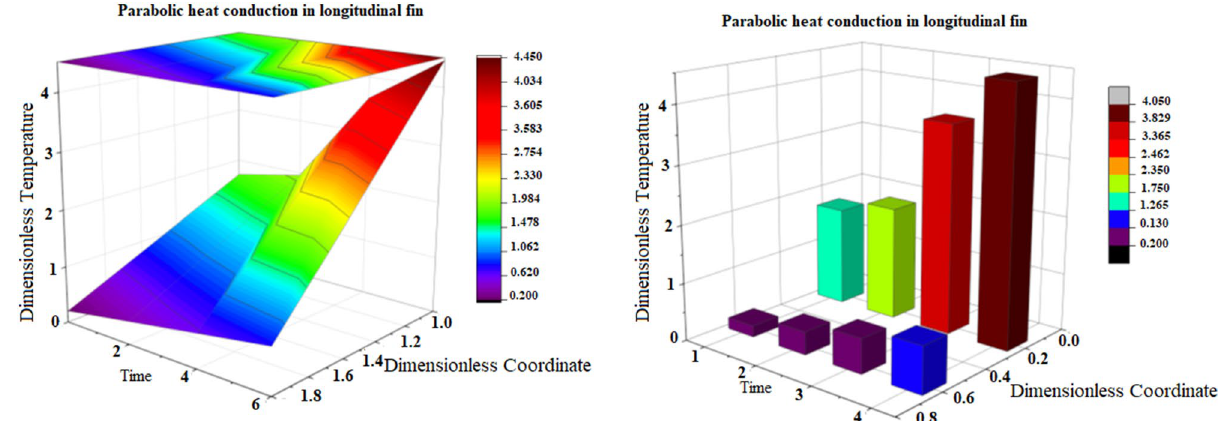
Figure 7. 3-dimensional and column graphs of parabolic heat conduction for the variants of fractional parameter for scatterings of temperature distribution with respect to time in seconds.